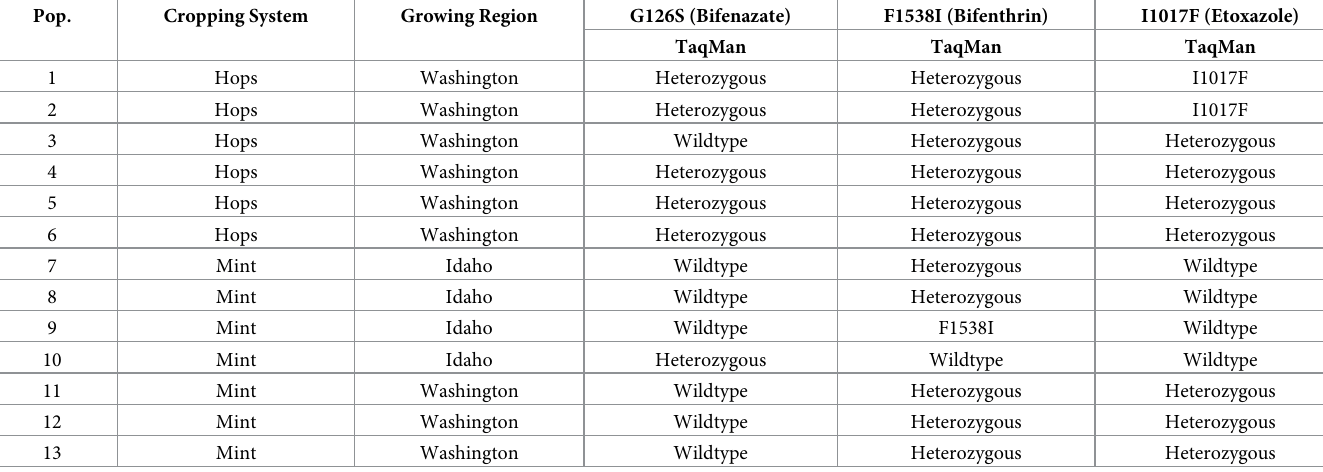
Table 1. TaqMan assay of T . urticae collected from hops and mint in the Pacific Northwest. Pop.